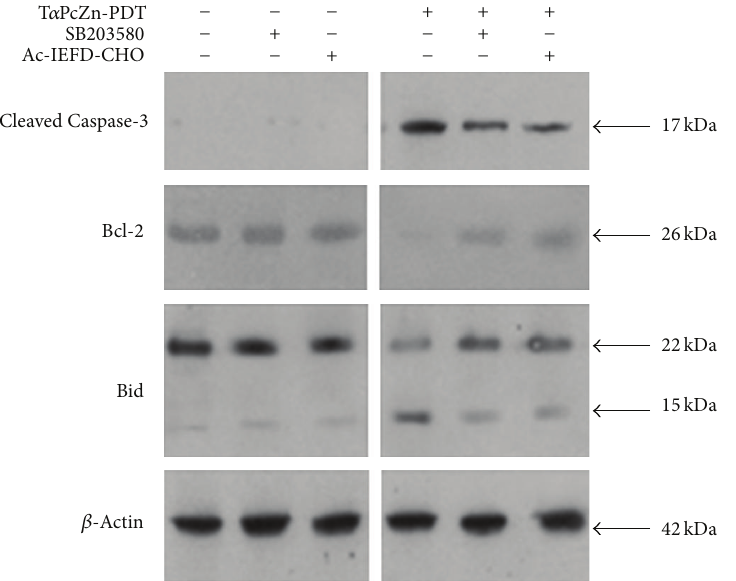
Figure 4: Effect of T 𝛼 PcZn-PDT on Caspase-3, Bcl-2, and Bid, respectively, without or with SB203580 or Ac-IEFD-CHO in T 𝛼 PcZn-PDT- induced apoptosis of Bel-7402 cells analyzed by immunoblot assay. Bel-7402 cells were pretreated with T 𝛼 PcZn (54 𝜇 M) in the absence or presence of SB203580 (10 𝜇 M) or Ac-IEFD-CHO (10 𝜇 M) for 2.5 h, exposed to red-light irradiation (53.7 J/cm 2 ), and then incubated for 3 h. Expression of cleaved Caspase-3, Bcl-2, and Bid was analyzed by immunoblot